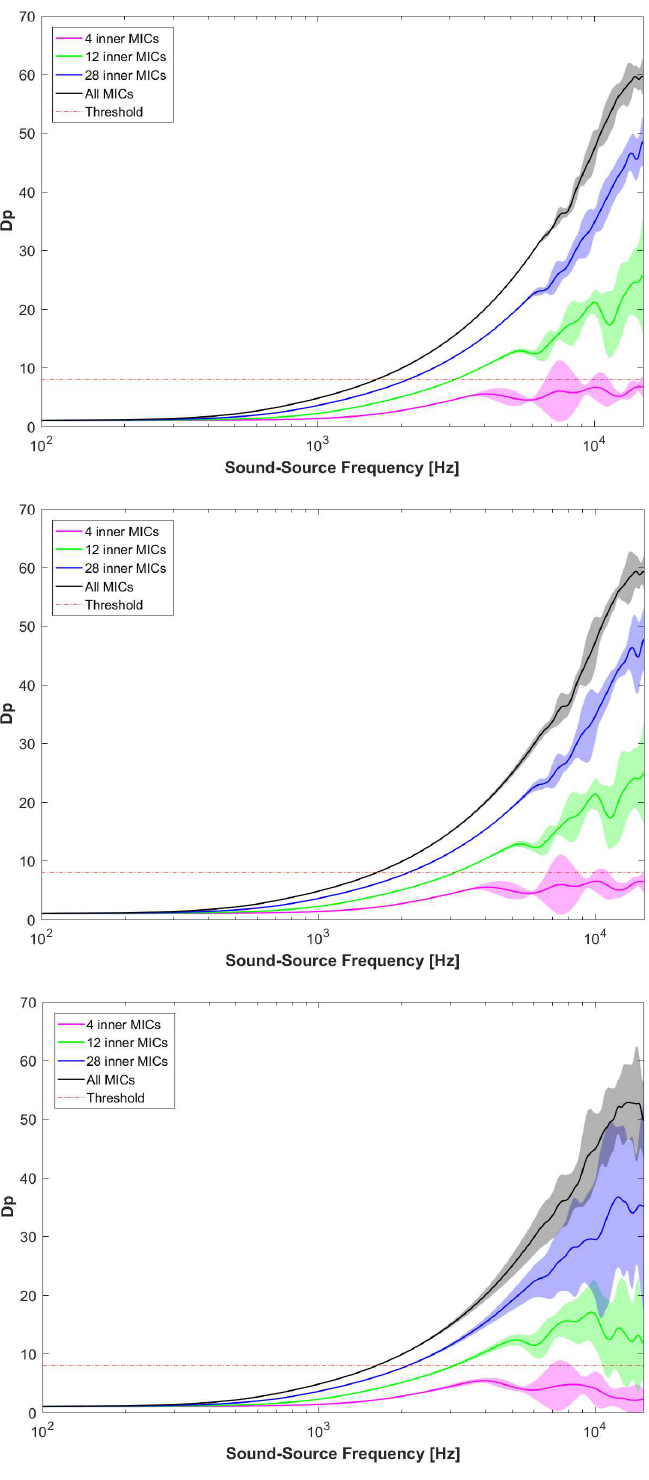
Figure 6. Comparison of the power-efficient architecture [29] ( top ), the presented architecture ( centre ) and the high- performance architecture [25,28] ( bottom ) using the 2D directivity [1] as metric done in [2]. The shadowed values represent the confidence interval for the 64 steered